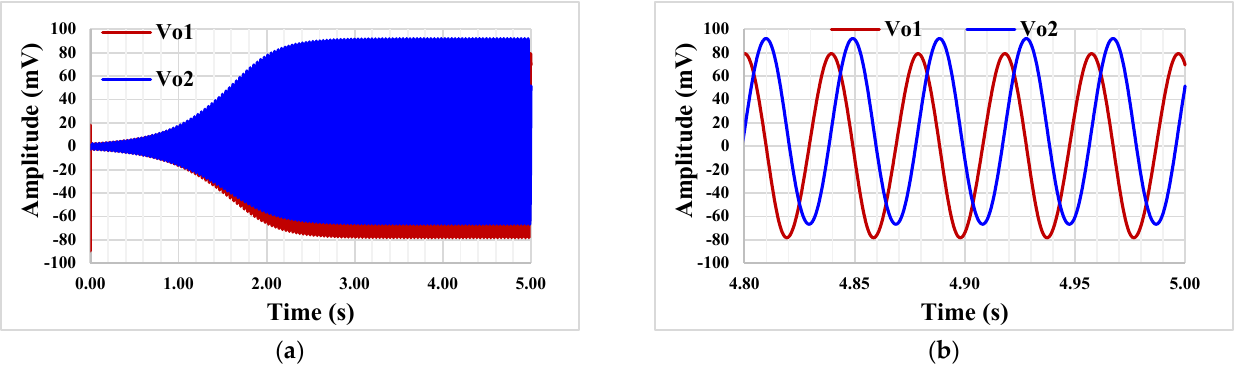
Figure 14. The frequency characteristics of the TM filter. The quadrature oscillator in Figure 6 was also simulated with I set = 5 nA and capacitor values C 1 = C 2 = 20 pF. Figure 15 shows the starting oscillation (a) and the steady state (b), respectively. The frequency is 253 Hz and the THD was around 1%.